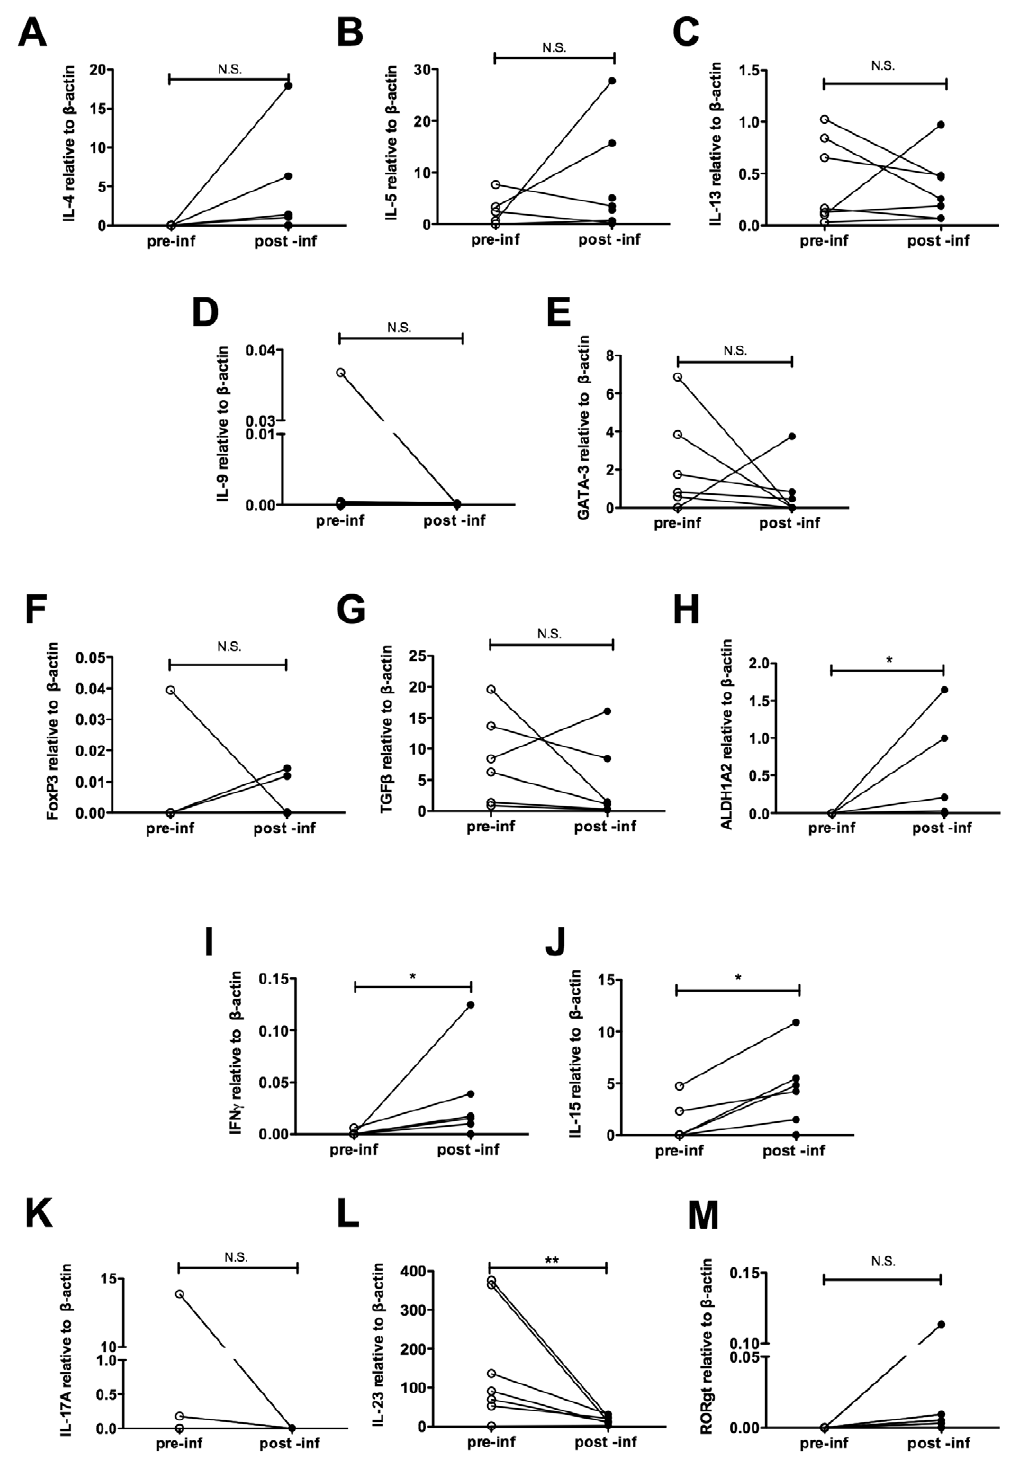
Figure 4. Exvivo cytokine gene expression in the duodenal mucosa of hookworm infected individuals. Duodenal biopsies from Trial 2 were taken before (week 0) and 20 weeks after hookworm infection, and RNA was prepared ex vivo . Levels of IL-4 (A) IL-5 (B), IL-13 (C), IL-9 (D), GATA-3 (E), Foxp3 (F), TGF- b (G), ALDH1A2 (H), IFN- c (I), IL-15 (J), IL-17A (K), IL-23 (L) and ROR c t (M) transcripts were determined by quantitative real time RT-PCR. doi:10.1371/journal.ppat.1002520.g004 detect an increase in Treg markers in response to hookworm induction following experimental helminth infections and admin- infection in this study, or when previously measured by FACS and istration of ES proteins in mouse models [30–32], and naturally immunohistochemistry [22], despite a wealth of evidence of Treg acquired infections of humans with other helminths [33,34].